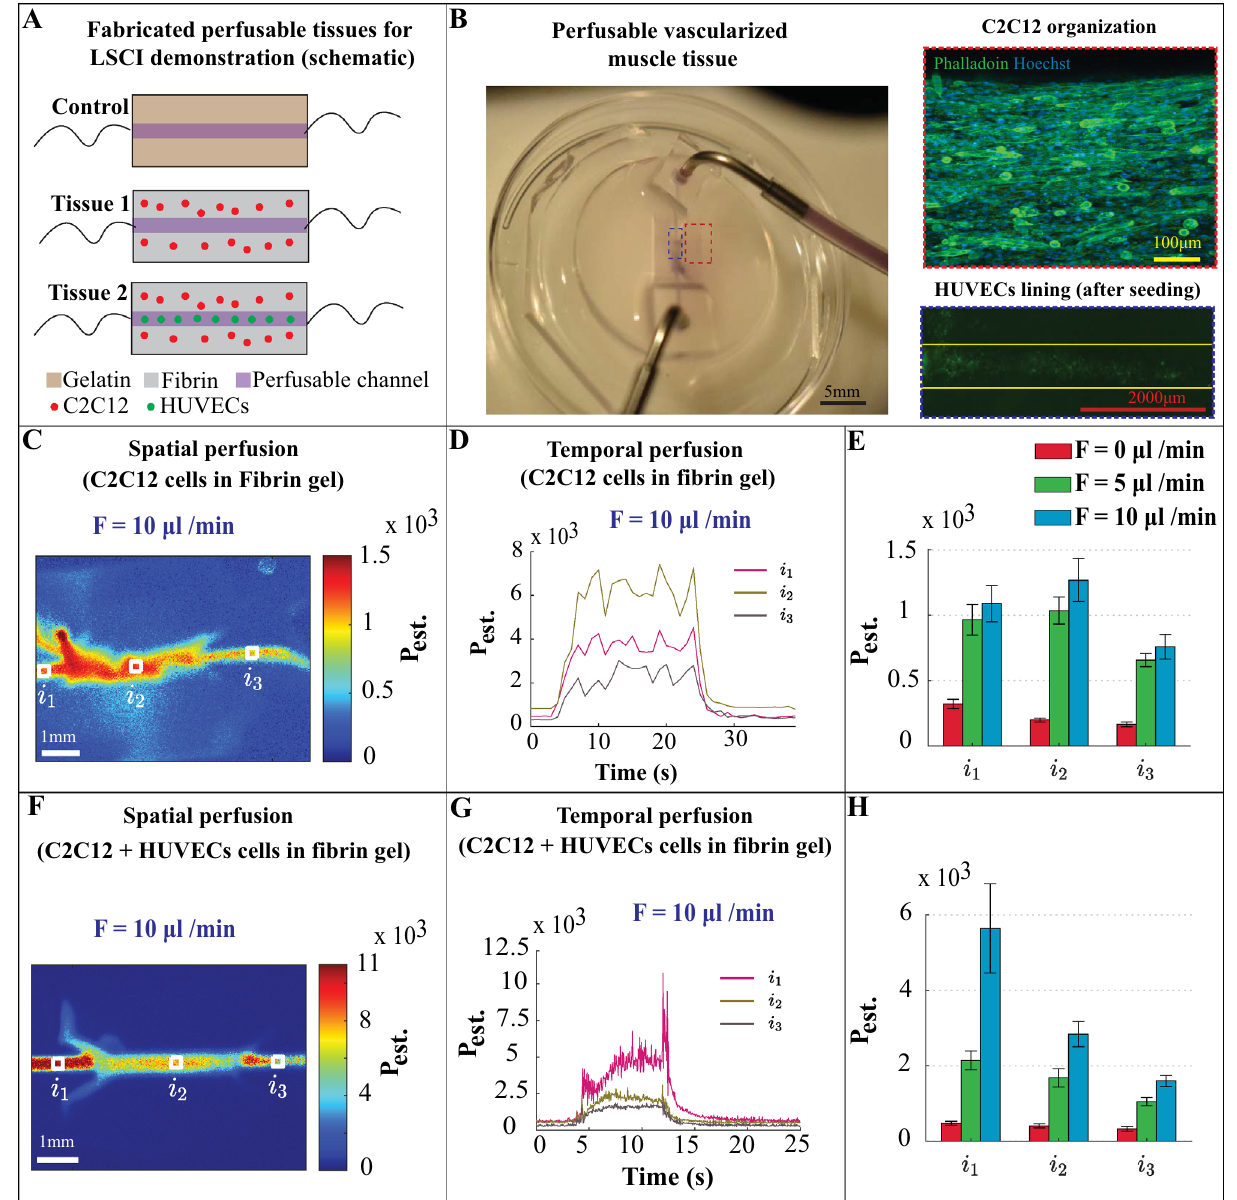
Figure 7. LSCI on perfusable muscle tissues. Panel ( A ) shows the schematic figure of three perfusable hydrogel tissue construct namely acellular gelatin hydrogel (control) , fibrin hydrogel with C2C12 cells (tissue 1) and fibrin hydrogel with C2C12 + HUVECs cells (tissue 2). Schematic figure were created using Adobe Illustrator. Data of gelatin hydrogel is illustrated in Supplementary Figure S5. Panel ( B ), left, shows an image of the perfusable muscle tissue construct with Intralipid-dye perfusion setup. Top right, a confocal microscope image of the C2C12 cellular organization and densities within tissue construct, highlighted with the dashed red box in the left image. Bottom right, a fluorescence microscope image of the channel area highlighted with the dashed blue box in the left image. Panel ( C ), illustrates the temporally averaged perfusion map ( ρ = 0.85) of the flow phantom with C2C12 cells with a flow rate of F = 10 μl/min for the case of tube on Delrin. Panel ( D ), illustrates the temporal profiles of the estimated perfusion ( F = 10 μl/min) associated with the white regions highlighted in Panel ( C ). Panel ( E ), illustrates the estimated perfusion for various flow rates. Panel ( F ) depicts the temporally averaged perfusion map ( ρ = 0.85) of the flow phantom with C2C12 and HUVECs cells with the flow rate of F = 10 μl/min for the case of tube on Delrin. Panel ( G ), depicts the temporal profiles of the estimated perfusion ( F = 10 μl/min) associated with white regions highlighted in Panel ( F ). Panel ( H ), depicts the estimated perfusion for various flow rates. Panels ( C , D , F , G ) are still images of Supplementary Video